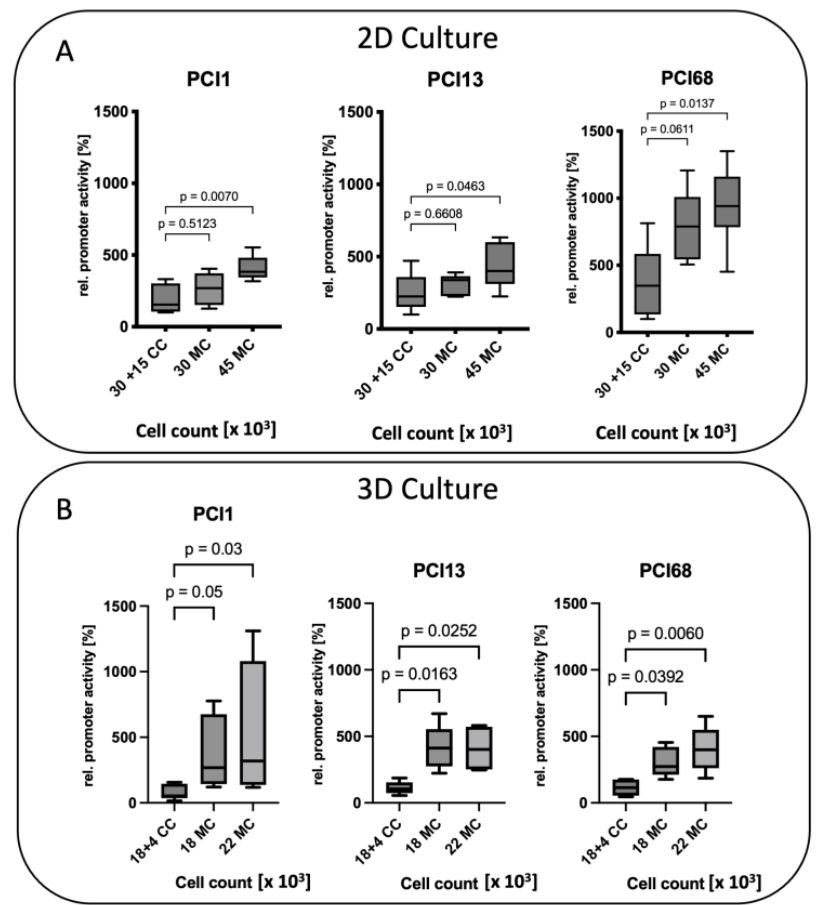
Figure 4. Decrease of MMP-9 promoter activity of HNSCC cells when co-cultured with BMSCs in direct 2D ( A ) and 3D co-culture ( B ). The relative MMP-9 promoter activity of HNSCC cell lines PCI 1, PCI 13 and PCI 68 when co-cultured with BMSCs (CC) was calculated. Their activity was compared with the MMP-9 promoter activity of HNSCC cells in mono-culture (MC). Relative promoter activity was calculated in relation to the mean value of activity from 2D/3D CC of the respective cell lines. Cell count × 1000. Statistical analysis: One way ANOVA. n = 5 – 6.